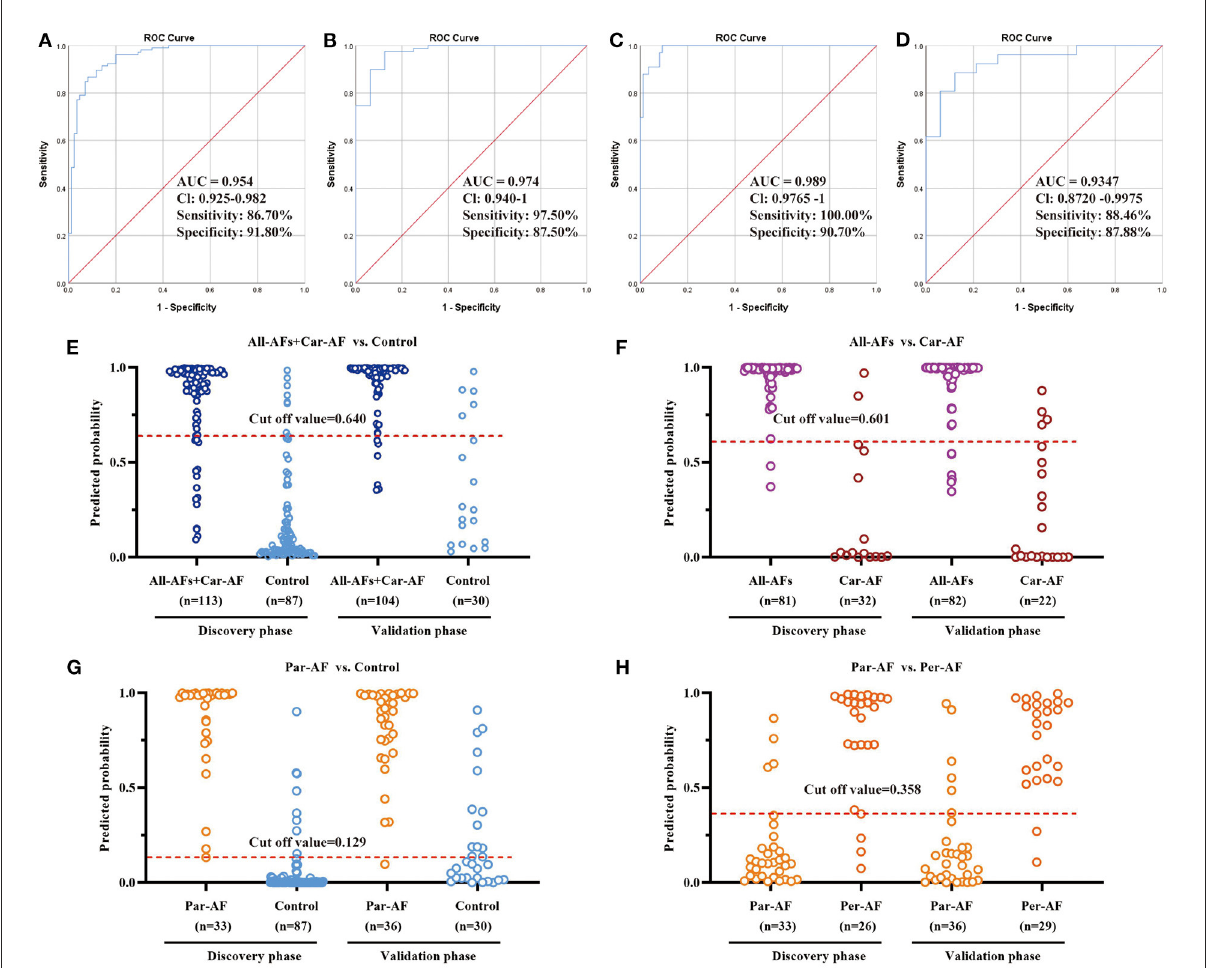
FIGURE7 Diagnostic Outcomes and Prediction Accuracies. The diagnostic outcomes in the discovery phase are shown via the ROC curves for comparison between (A) All-AFs plus Car-AF versus Control, (B) All-AFs versus Car-AF, (C) Par-AF versus Control, and (D) Par-AF versus Per-AF. The prediction accuracies by the biomarkers in the validation set were compared between (E) All-AFs plus Car-AF versus Control, (F) All-AFs versus Car-AF, (G) Par-AF versus Control, and (H) Par-AF versus Per-AF. AUC, area under the curve; CI, confidence